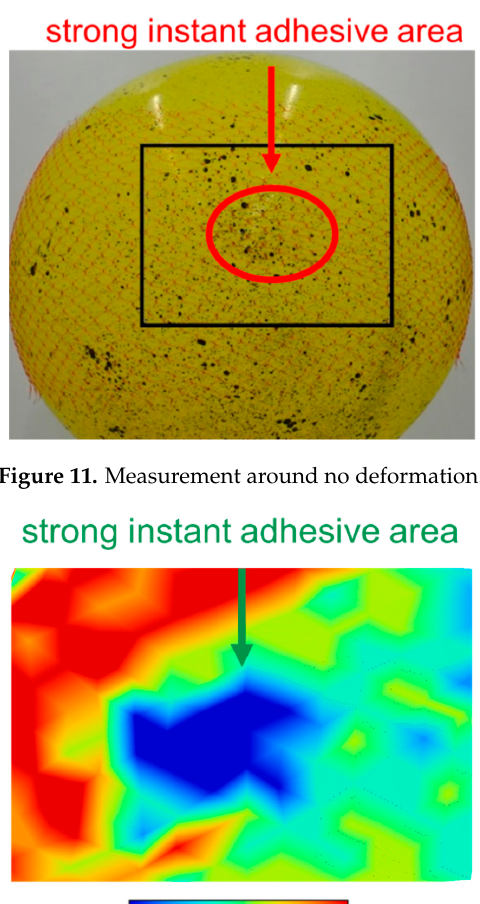
Figure 10. Misrecognition of the deformation of the net by DIC.